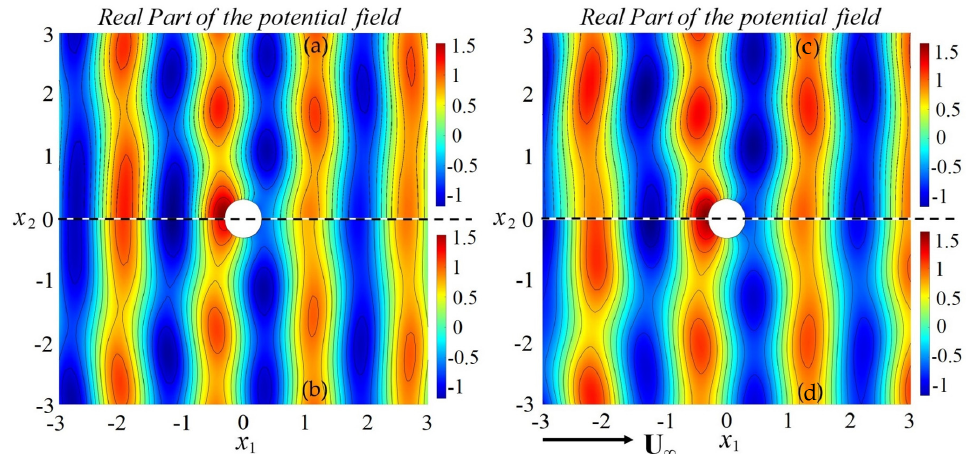
Figure 12. Real part of the symmetric field on the horizontal plane, in water depth h = 1 m, for a wave at frequency f = 1Hz, interacting with a cylinder of radius 0.3 m without current, as calculated by ( a ) the 3D BEM and ( b ) the proposed 2D FEM scheme. Calculated field for waves of the same frequency and height in the presence of a current of speed U ∞ = 0.1m/s as calculated by ( c ) the present 3D BEM and ( d ) the proposed 2D coupled BEM–FEM scheme.